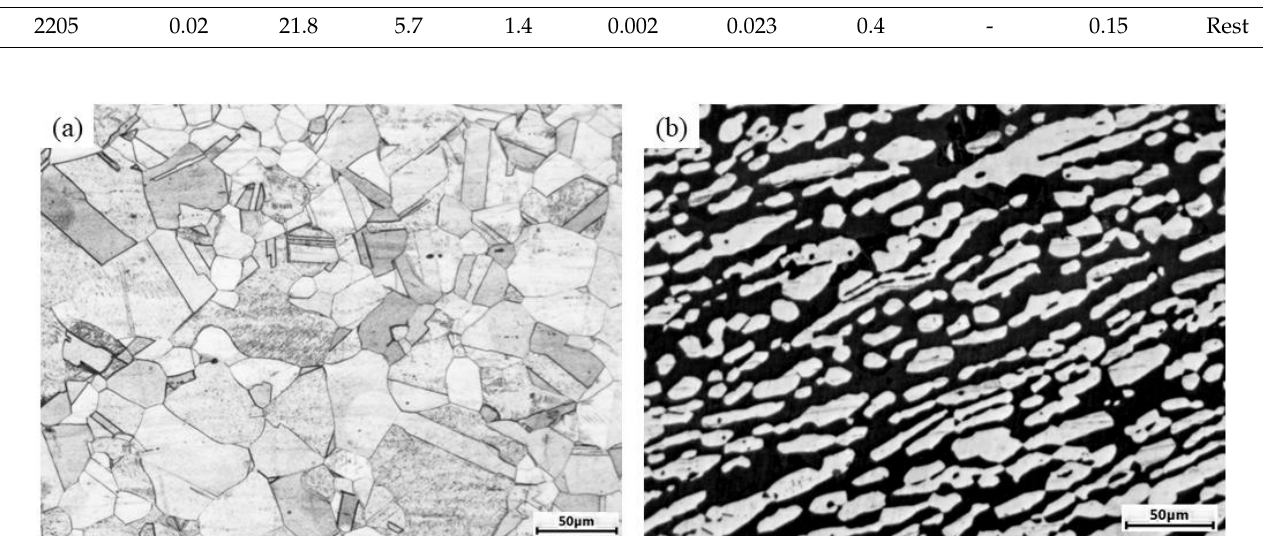
Figure 1. OM-based microstructures of ( a ) 316L and ( b ) 2205.